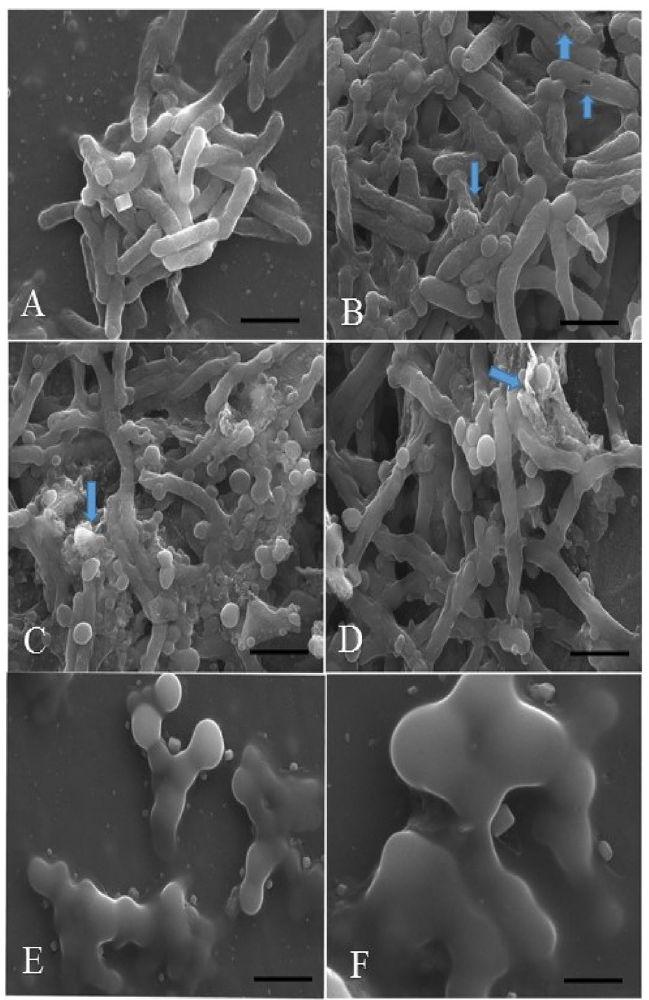
Figure 10. Antimicrobial mode of action. ( A ) GO exposed E. coli cells. The cells were found to be coated with the graphene oxide sheet. ( B ) SF@GOC exposed E. coli cells. The cells were found to be wrapped with the SF@ GOC sheets and also the perforation/puncture in the cells are observed (marked with the blue arrows). ( C ) SF@GOC exposed P. aeruginosa cells. The cells were enclosed in the nanomaterial. ( D ) SF@GOC exposed P. aeruginosa cells. The cells leakage was observed after complete wrapping of the cells. ( E , F ) SF@GOC exposed S. aureus cells. Complete shape deformation observed. *(scale bar of all images are 1